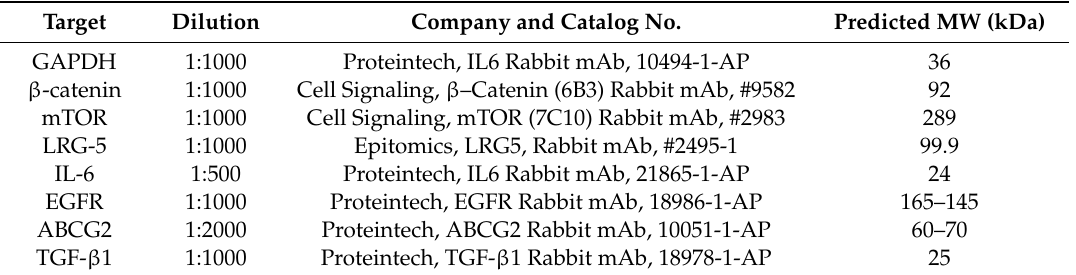
Table 1. List of